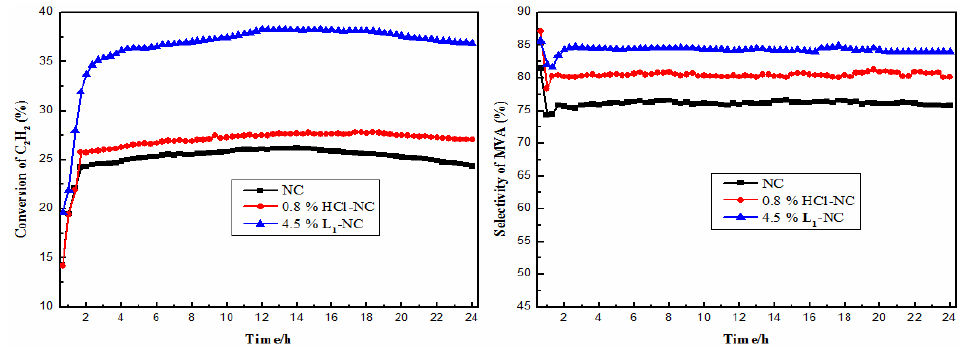
Figure 3. Catalytic performance of NC, 4.5% L 1 -NC and 0.8% HCl–NC. (Reaction conditions: Space velocity of acetylene 105 h −1 , reaction temperature 80 °C). Table 3. Lifetime testing for three catalysts of NC, 4.5% L 1 -NC and 0.8% HCl–NC. Catalysts Acetylene Conversion